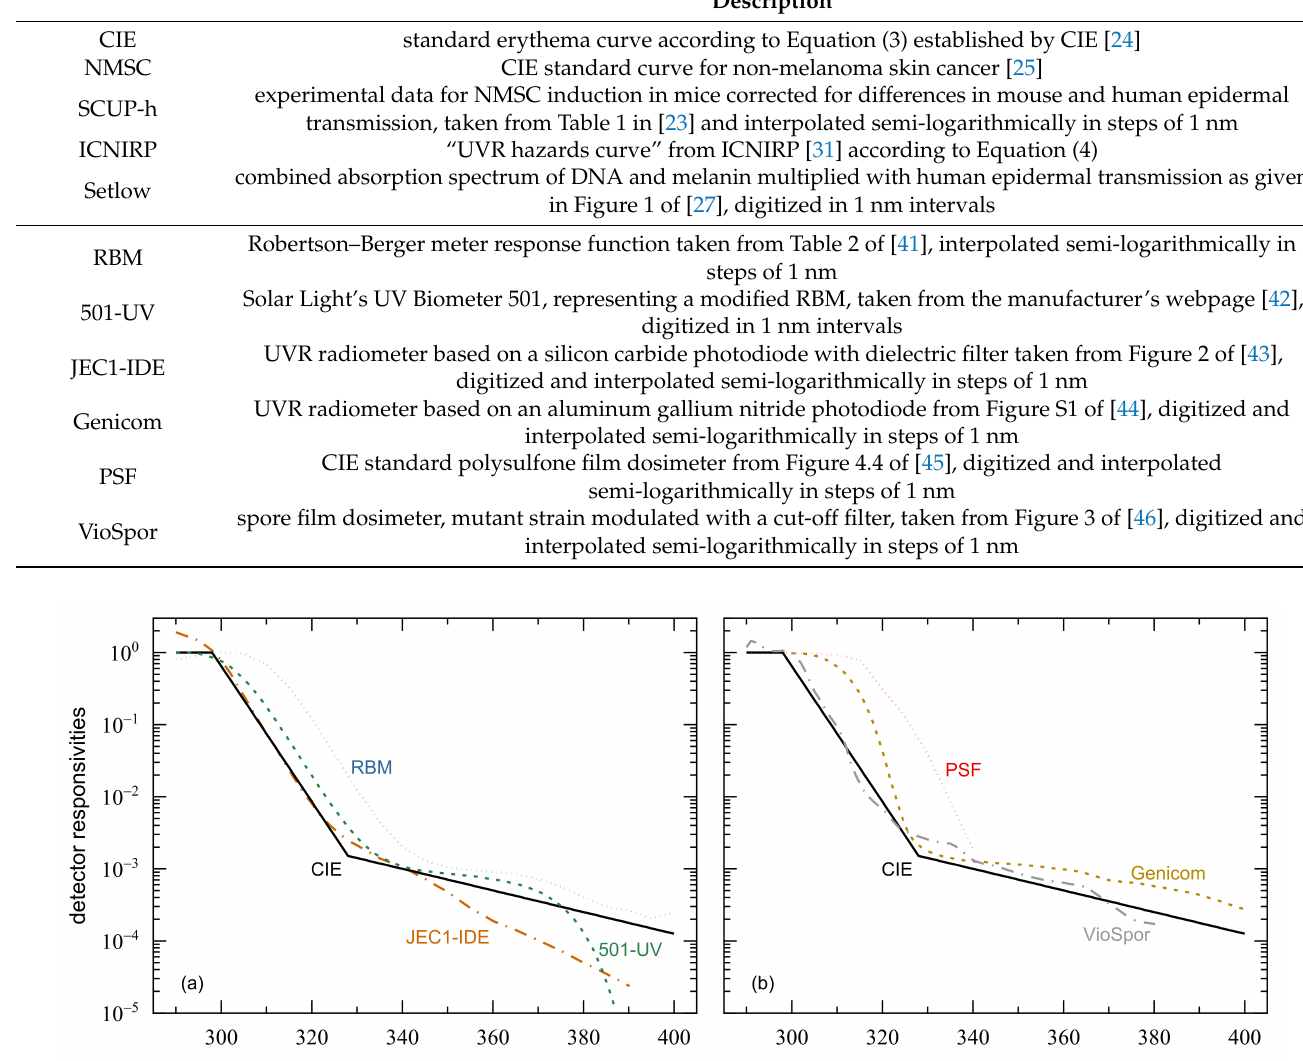
Table 1. Information on the action spectra and detector responsivities presented in Figures 1 and 2, respectively. Description